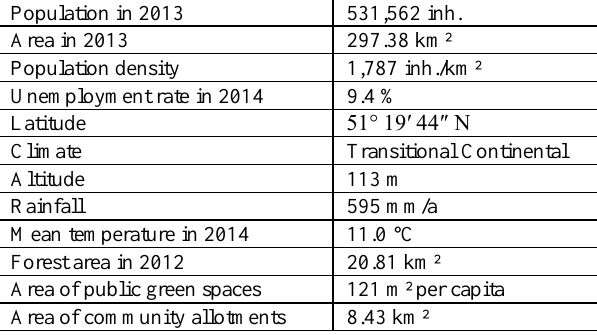
Table 1. Socio-demographic and environmental indicators for the City of Leipzig (Source: City Council of Leipzig)